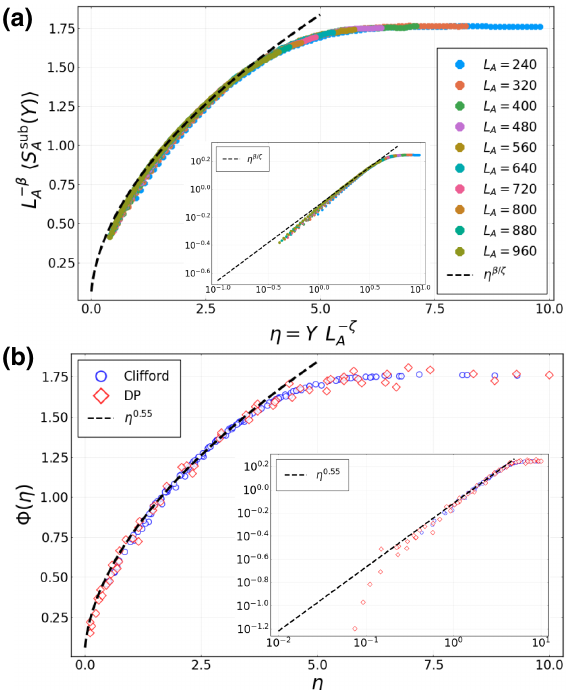
FIG. 5. (a) The sample-to-sample deviation of entanglement entropy δ S A ( Y ) [see Eq. (14)] in the Clifford circuit for various values of L A and Y , collapsed against the scaling function (cid:12)(η) [defined in Eq. (21)]. (b) The scaling function (cid:12)(η) extracted from δ F A ( Y ) in a numerical simulation of directed polymers, rescaled and plotted on top of the same scaling function extracted from (a). The directed polymers have length L A ≤ 32768 and live at zero temperature [see Eq. (10)]. For both the Clifford cir- cuit and the directed polymers we take the best fits β = 0.33, ζ =